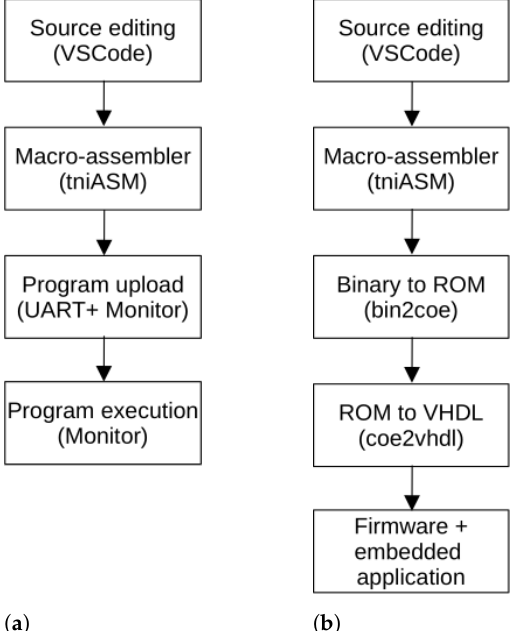
Figure 9. Flow of the Dracon toolchain for ( a ) compiling and executing applications and ( b ) firmware and/or embedded